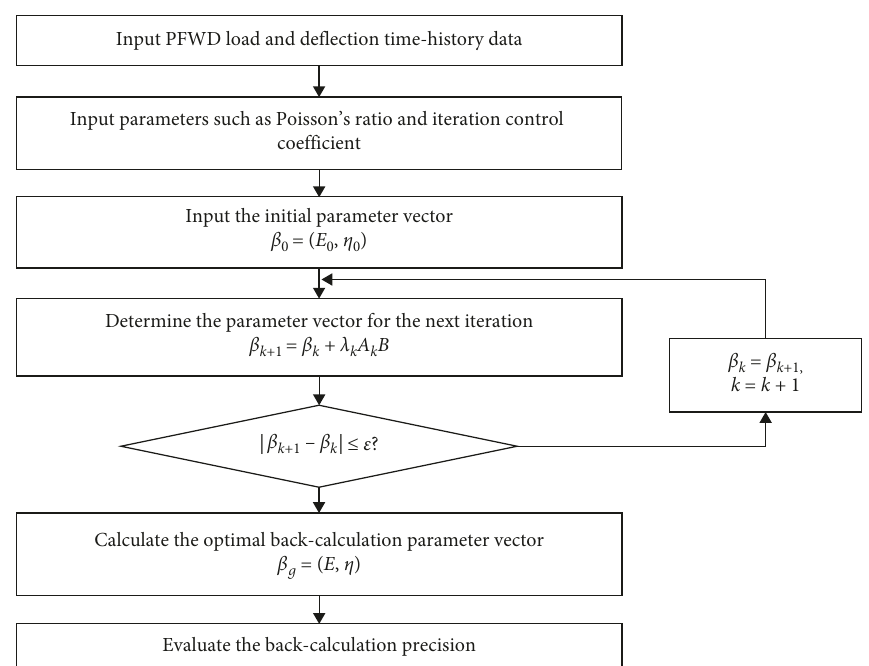
Figure 8: Proposed back-calculation